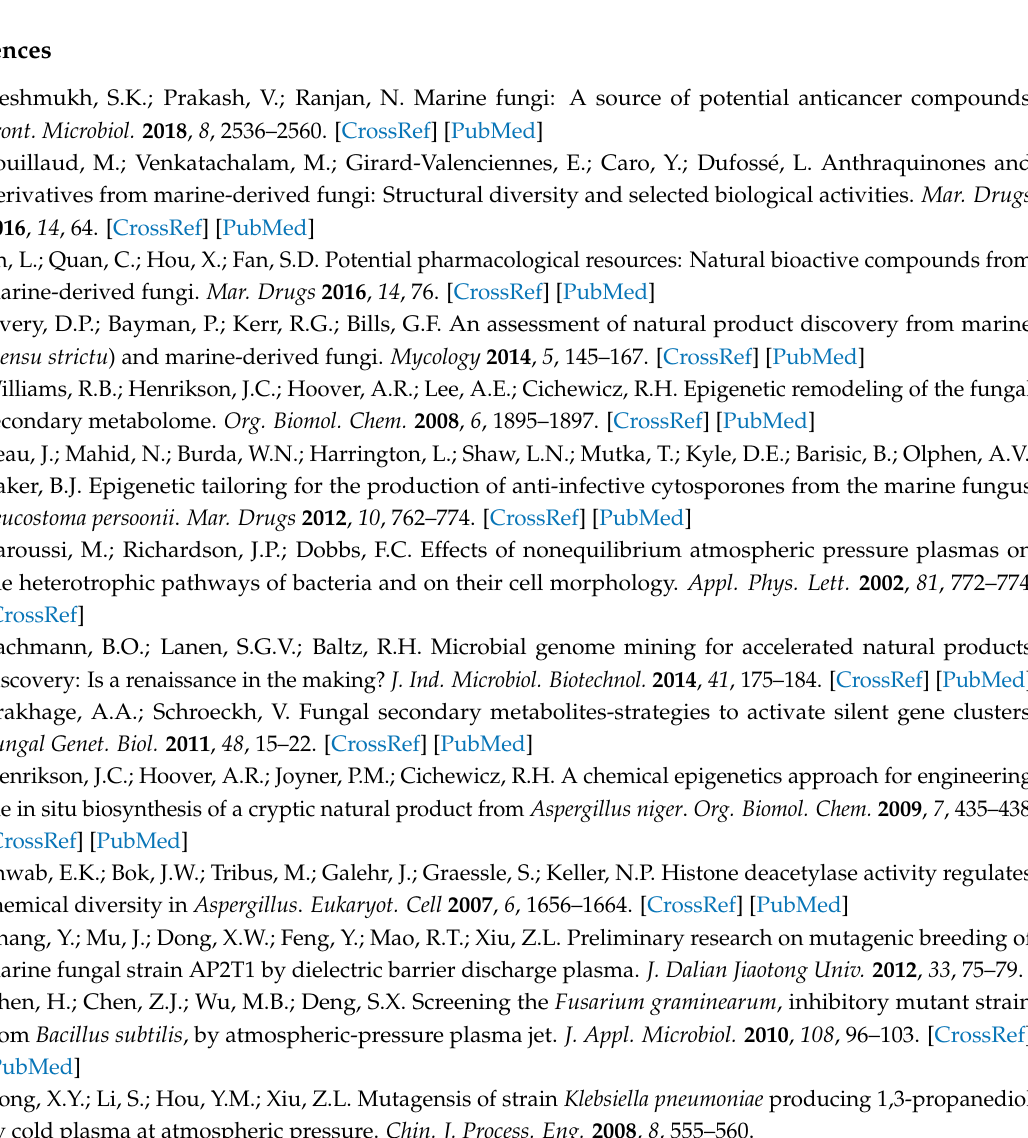
Supplementary Materials: The following are available online. Figure S1: 500 MHz for 1H-NMR Spectrum of 1 in CD3OD; Figure S2: 125 MHz for 13C-NMR Spectrum of 1 in CD3OD; Figure S3: 500 MHz for 1H–1H COSY Spectrum of 1 in CD3OD; Figure S4: 500 MHz for HSQC Spectrum of 1 in CD3OD; Figure S5: 500 MHz for HMBC Spectrum of 1 in CD3OD; Figure S6: 125 MHz for Dept 135 Spectrum of 1 in CD3OD; Figure S7: HR-ESI-MS of 1; Figure S8: Optimized structure of 1 ; Figure S9: Optimized structure of 9